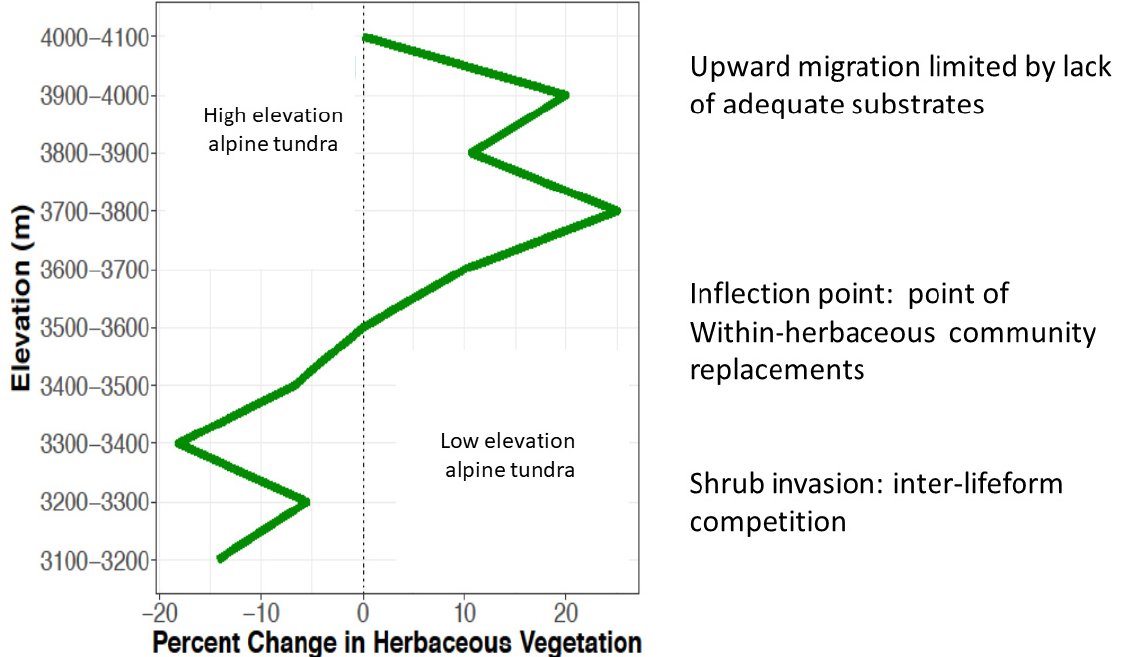
Figure 3. Vegetation uphill movements, 1972–2008. Viewed from the perspective of relative herbaceous vegetation cover change at Niwot Ridge, Colorado; shrub invasion reduces herbaceous species cover at lower elevations. Midway up the mountain, community change within herbaceous communities dominated, while at uppermost elevations herbaceous vegetation colonization of what was largely bare rock and scree habitats is ongoing (redrawn from De Mesquita et al. [51]).